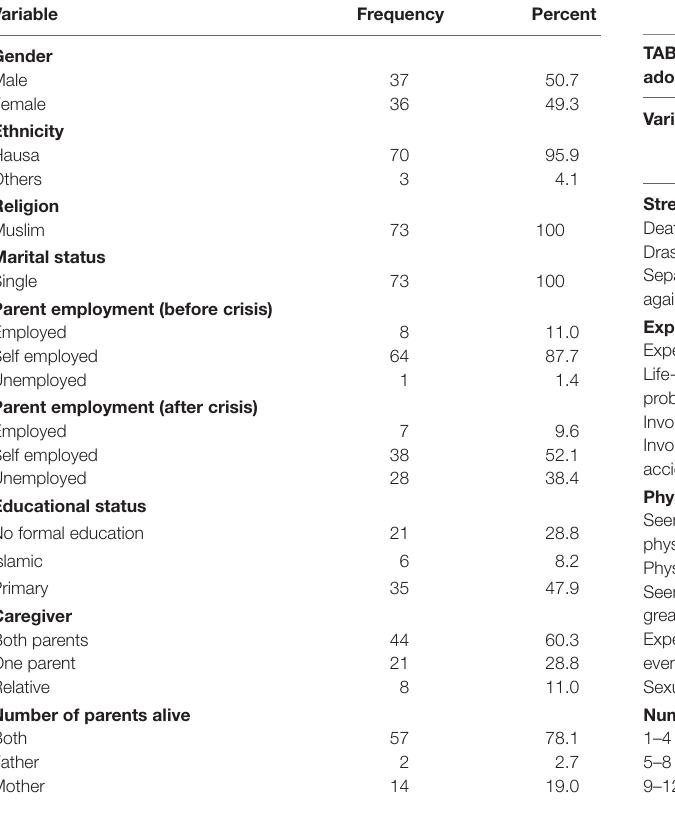
TaBle 1 | sociodemographic characteristics of child and adolescent, iDPs, Kaduna, nigeria ( n = 73). Variable